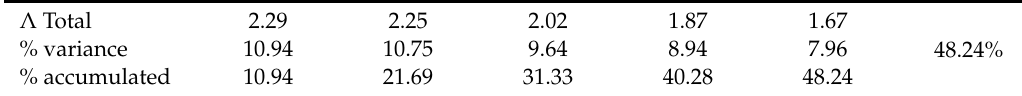
Table 6. Λ total and % variance.